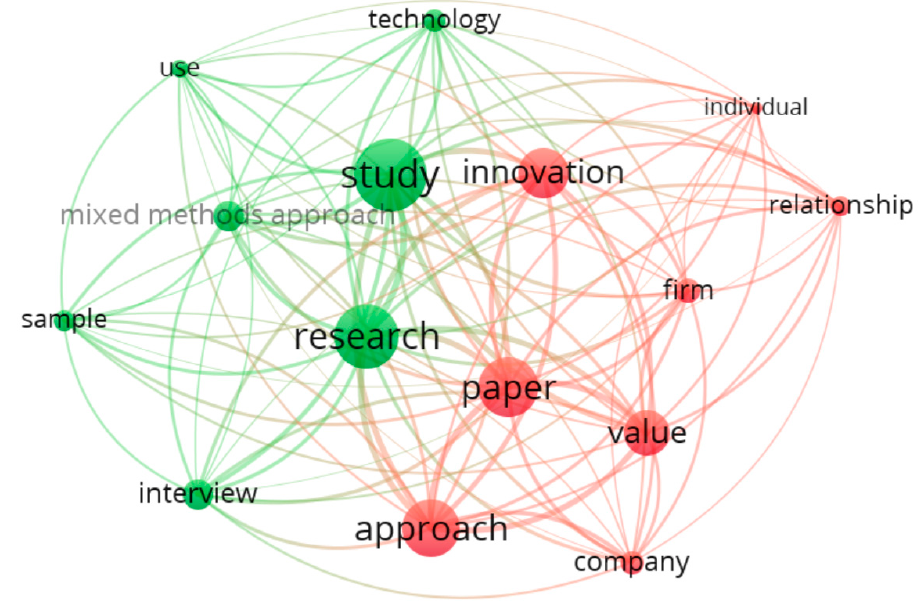
Figure 7. Keywords co-occurrence network with colored clusters, node size by number of occurrences (source: own study).